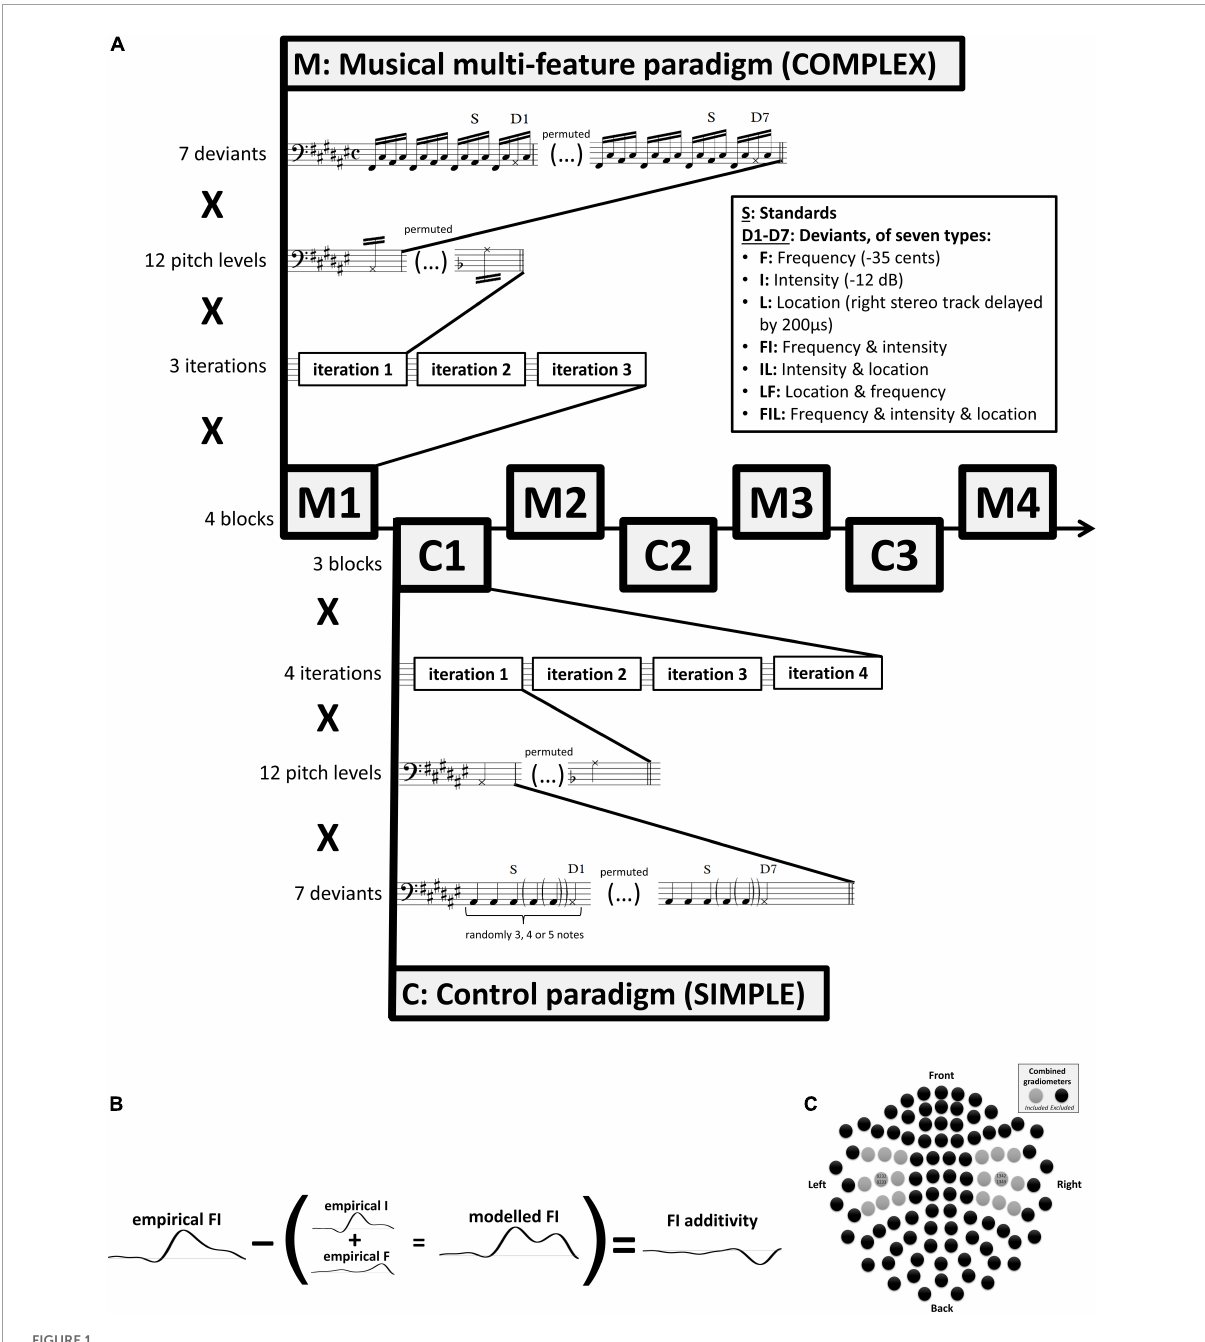
FIGURE1 (A) Experimental procedure. Stimuli were presented in alternating blocks using the complex musical multi-feature paradigm (M1–M4) and the simple control paradigm (C1–C3). Each block comprised three (M) or four (C) iterations of a sequence of standards and deviants presented at twelve varying pitch levels (i.e., chromatic range of A#2–A3). At each pitch level, seven deviant types were used in permutation. These comprised three single deviants differing in frequency (-35 cents), intensity (-12 dB), or location (right stereo track delayed by 200 µ s), double and triple deviants differing in frequency and intensity, intensity and location, location and frequency, or frequency and intensity and location. Epoching of the magnetoencephalographic recordings was time-locked to the onset of the musical notes marked with S for standards and D for deviants. (B) Additivity analysis. The additivity of neural mismatch responses was computed by subtracting modeled MMNms—corresponding to the sum of the two or three constituent single-deviant MMNms—from the empirical MMNm obtained in response to the relevant double or triple deviant. (C) The 18 combined gradiometers from the Elekta Neuromag TRIUX system that were used in analysis centered on the two sensors—MEG1342 + 1343 and MEG0232 + 0233—exhibiting the peak grand-average MMNm amplitude across both paradigms and across all participants and